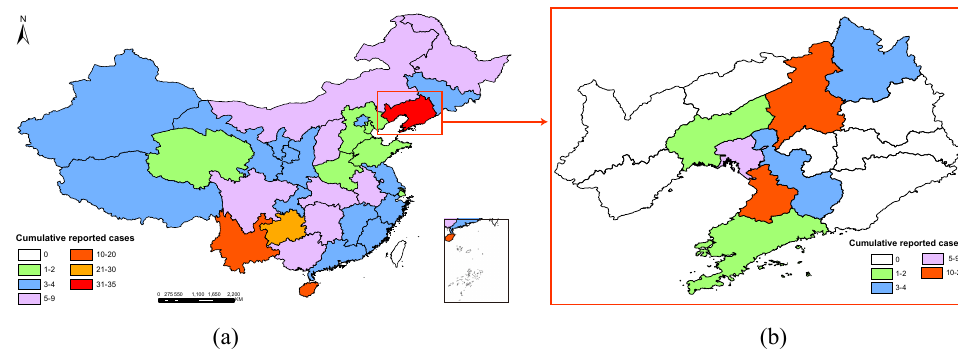
Figure 2. From 1 August 2018 to 31 August 2019: ( a ) Spatial distribution of incidence of ASF at the province level in Mainland China. ( b ) Spatial distribution of incidence of ASF at the city level in Liaoning